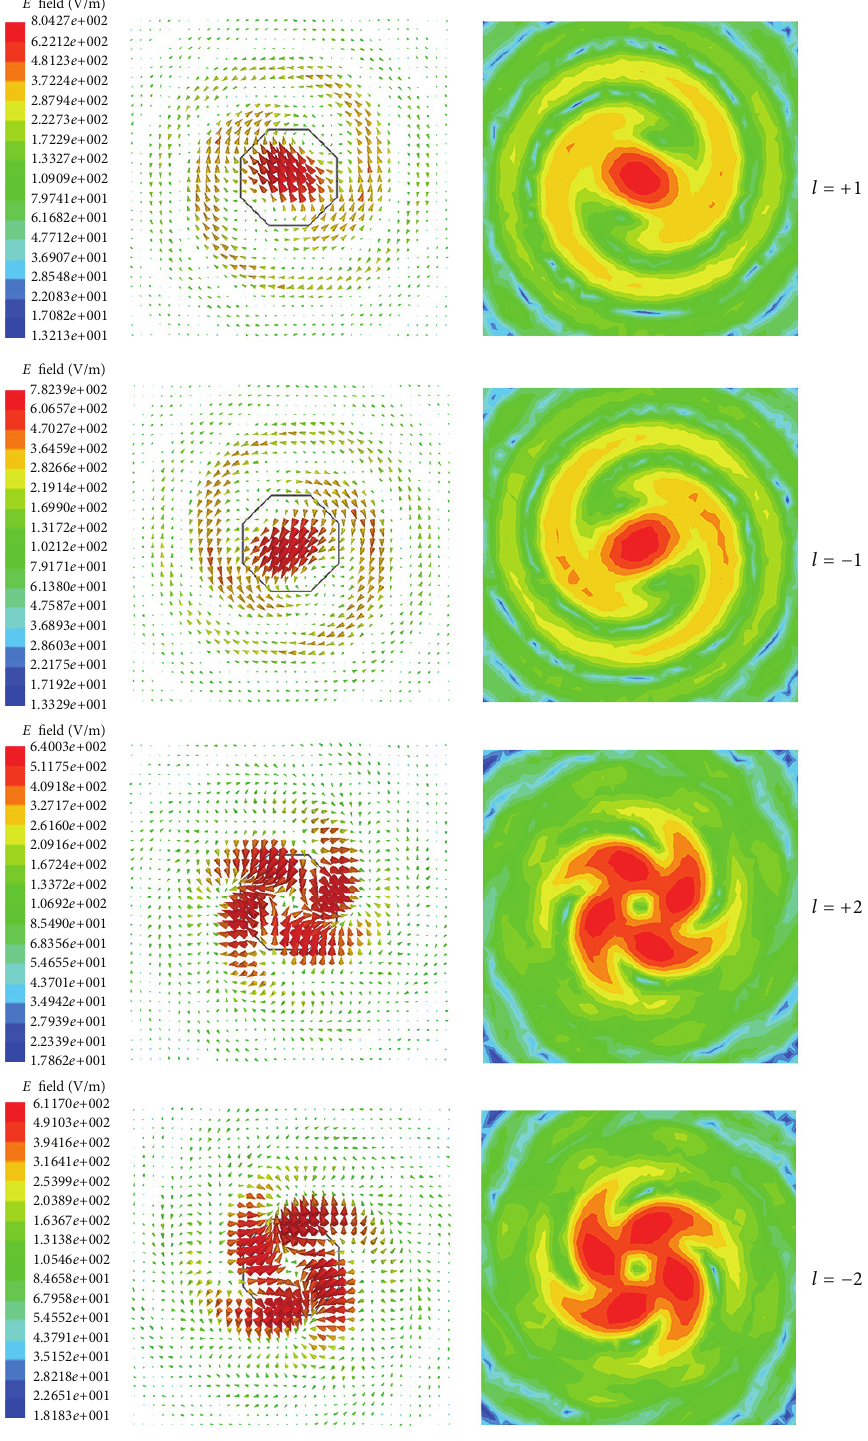
Figure 6: The vector and magnitude of electric field with different OAM states at